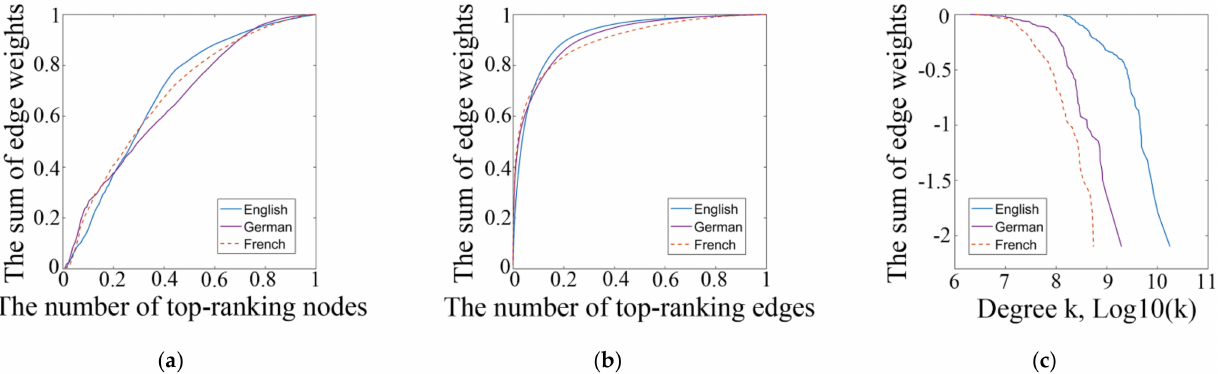
Figure 2. Distribution of dyadic weights and nodal degree centralities ( a ) across city nodes and ( b ) across city dyads, and ( c ) cumulative distribution of degree